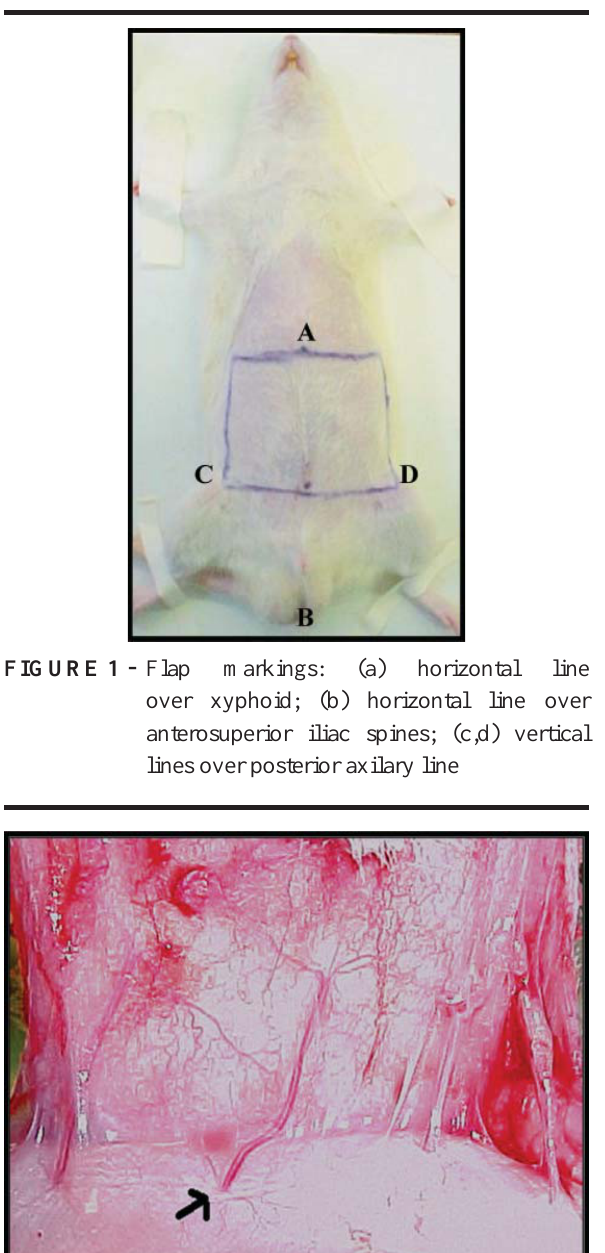
FIGURE 2 - Flap harvested. Perforator vessels in na upward direction. Arrow on 2nd perforator vessel, which was preserved in every animal Experiment